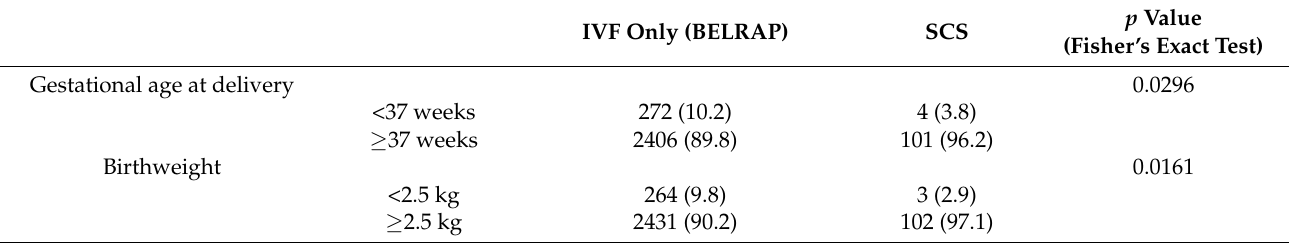
Table 3. Preterm birth and low birthweight comparison between SCS and BELRAP “IVF-only” singletons born after fresh ET, before adjustment—number (%).